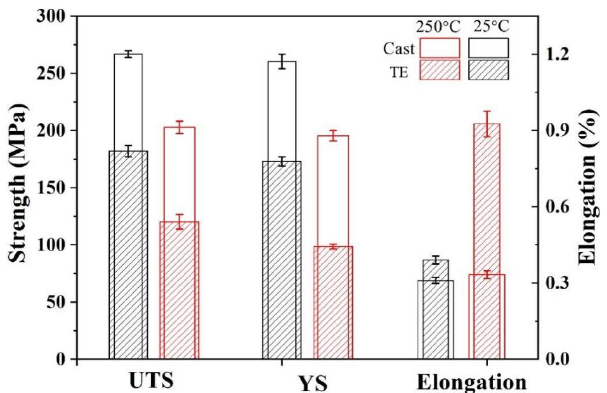
Figure 7. Tensile properties of the Al-Si-Cu-Ni-Mg alloy measured at different states (TE represents thermal exposure at 250 °C for 200 h).